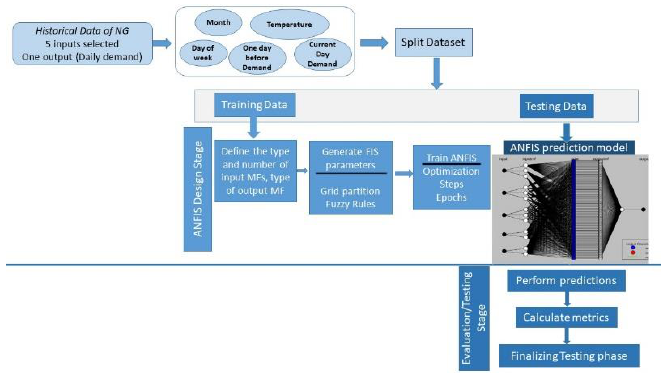
Figure 2. Flowchart of the proposed adaptive neuro-fuzzy inference system (ANFIS) methodology.